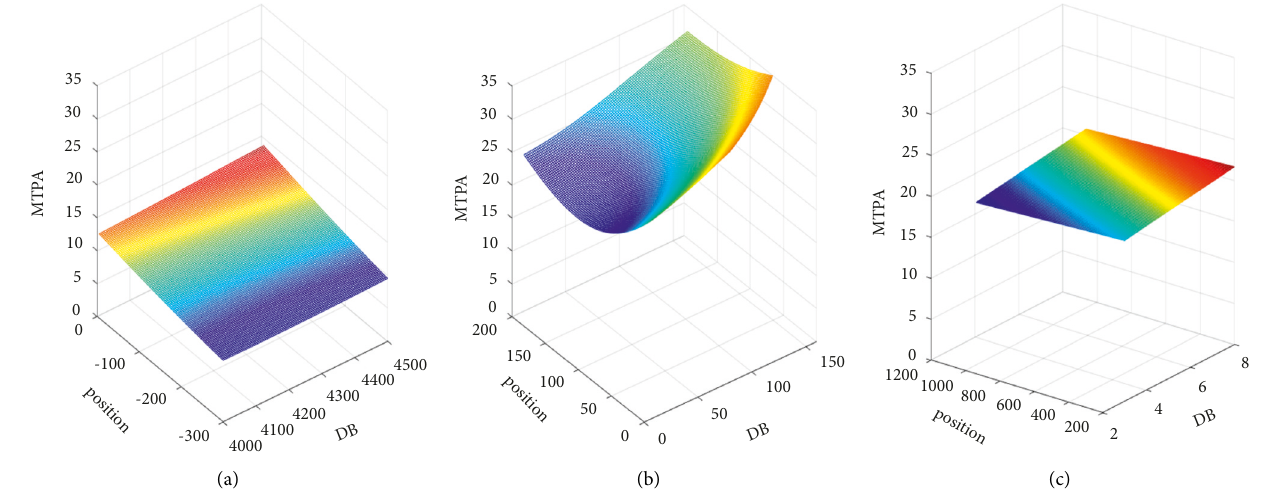
Figure 9: The influence of design brightness and position on MTPA in stages 1–3. (a) Stage 1. (b) Stage 2. (c) Stage